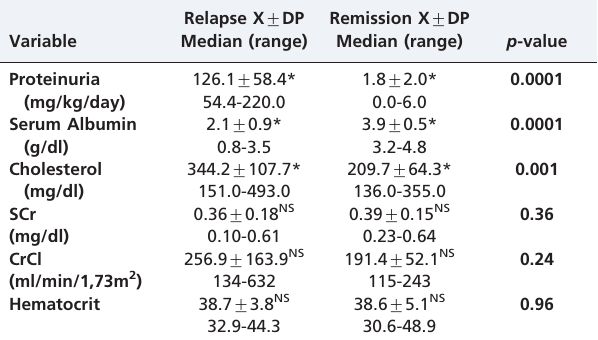
Table 2 - Nephrotic Syndrome parameters evaluated during remission and